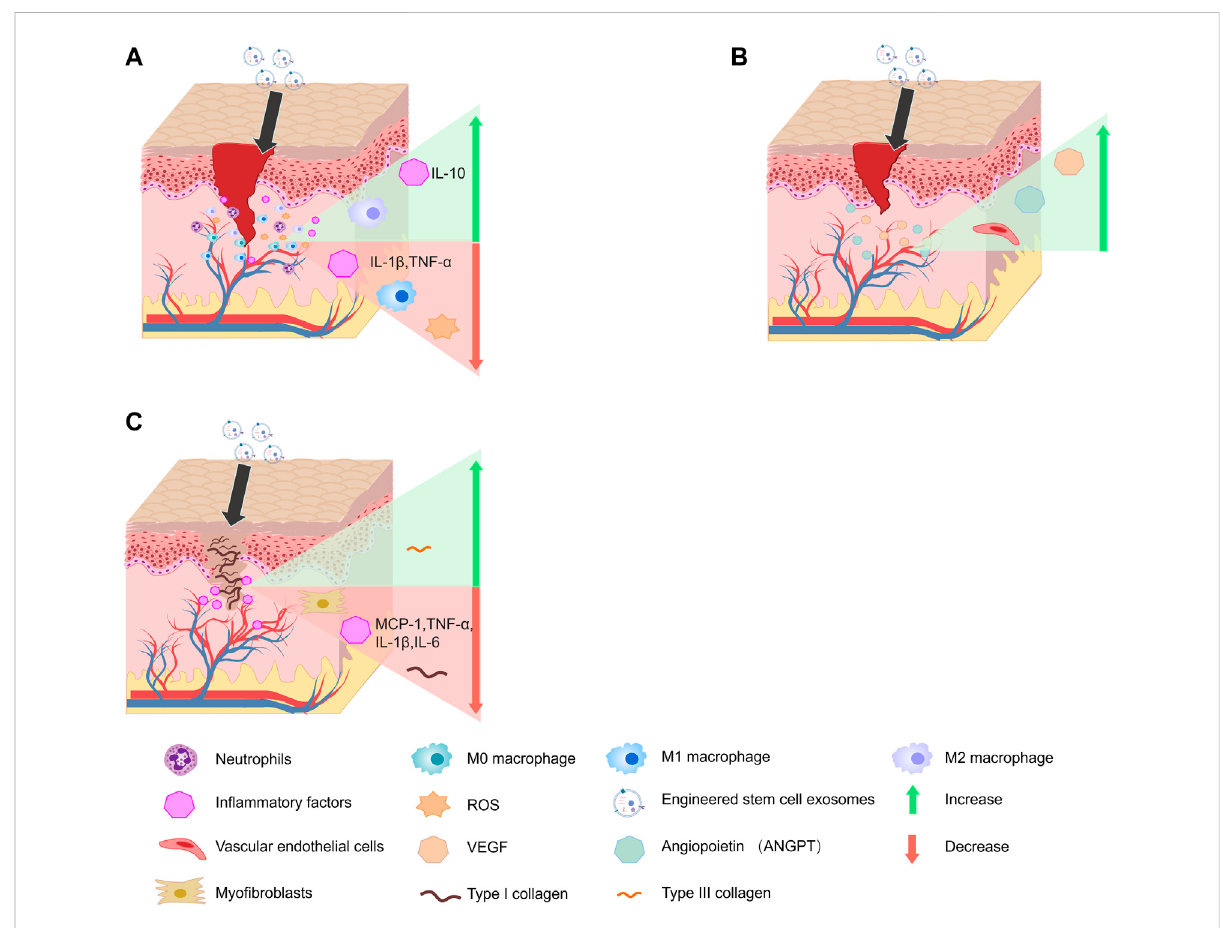
FIGURE 2 Effect of engineered stem cell exosomes on wound healing. (A) Engineered stem cell exosomes decrease the levels of in fl ammatory factor. (B) Engineered stem cell exosomes promote angiogenesis. (C) Engineered exosomes decrease scar